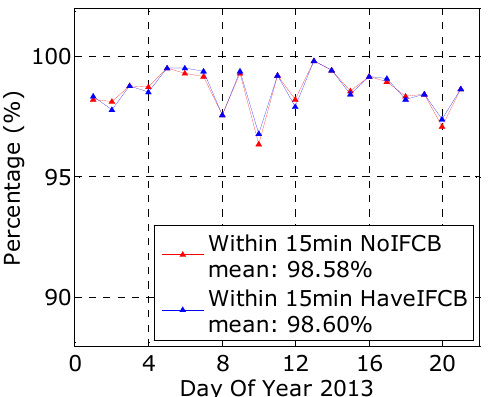
Figure 10. Fixing percentage for kinematic PPP with different strategies for an observation duration of 15 min on each day. Receivers with homogeneous type are used as rover sites.